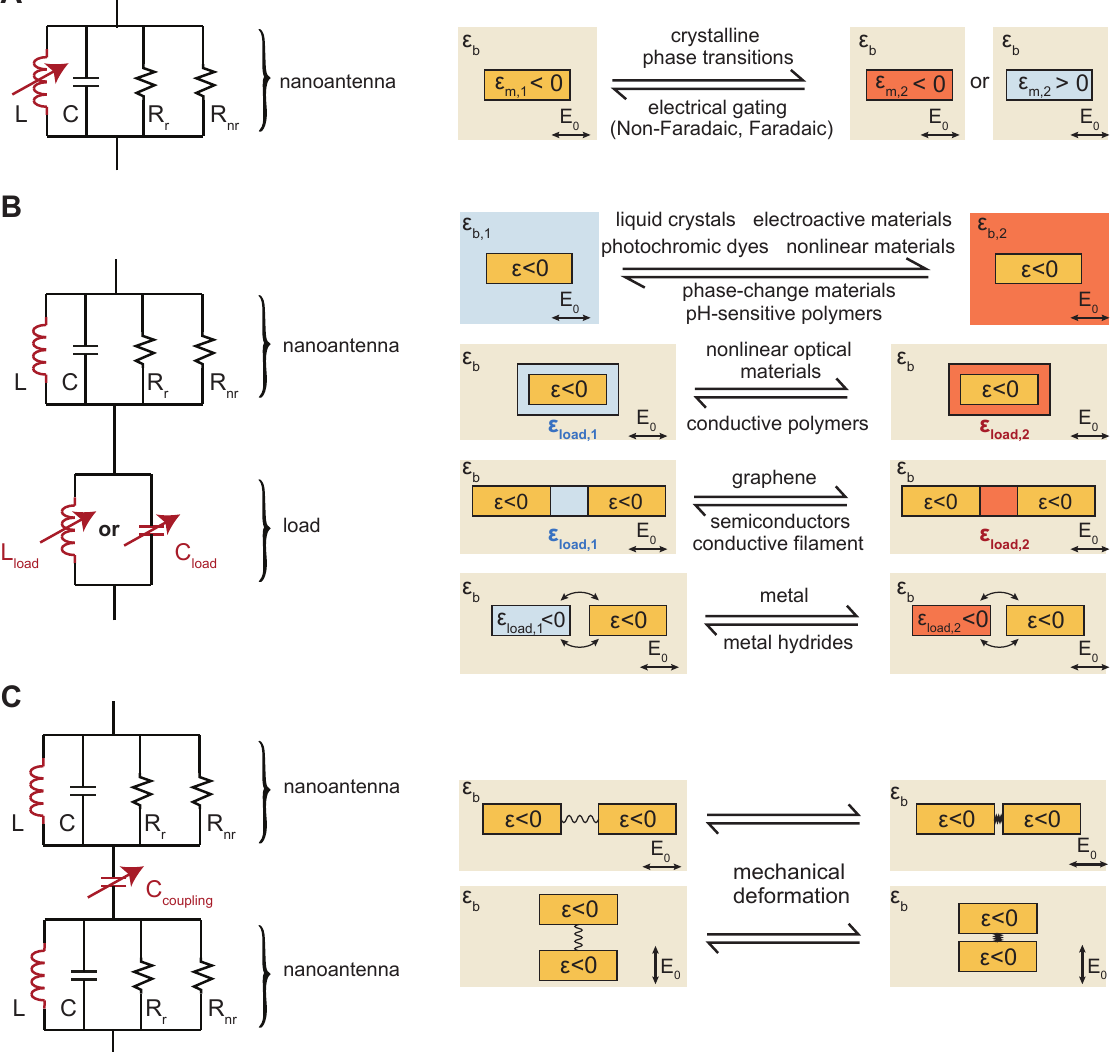
Figure 6: Mechanisms employed for active PNAs with the corresponding lumped optical nanocircuit equivalents: (A) Modulations in the optical dielectric constants of a PNA metal are captured using tunable nanoinductors; (B) Modulation of PNA characteristics through the coupled dielectric medium is incorporated using a tunable load consisting of nanocapacitors or nanoinductors; (C) Modulation of the near- field coupling between PNA elements is represented by tunable nanocapacitors. (A) – (C) The left panel shows the lumped optical nanocircuit representation of active PNAs for various tuning mechanisms. The right panel illustrates reversible tuning of PNA response through material characteristics based on different physical phenomena. PNA, plasmonic nanoantenna. r, radiative; nr,